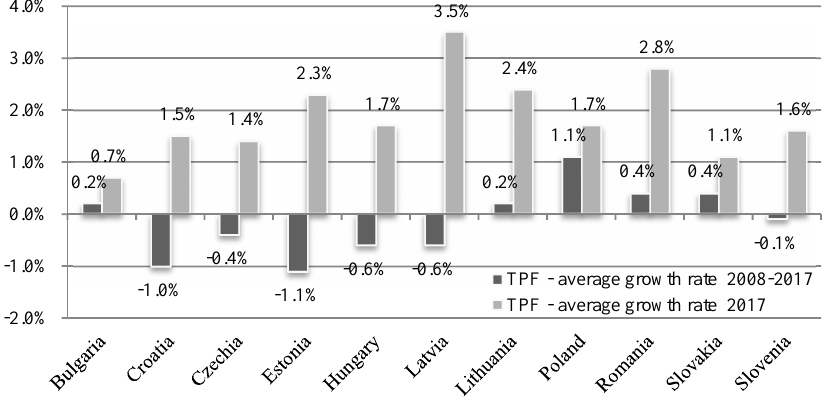
Figure 1. TFP growth rates in CEE